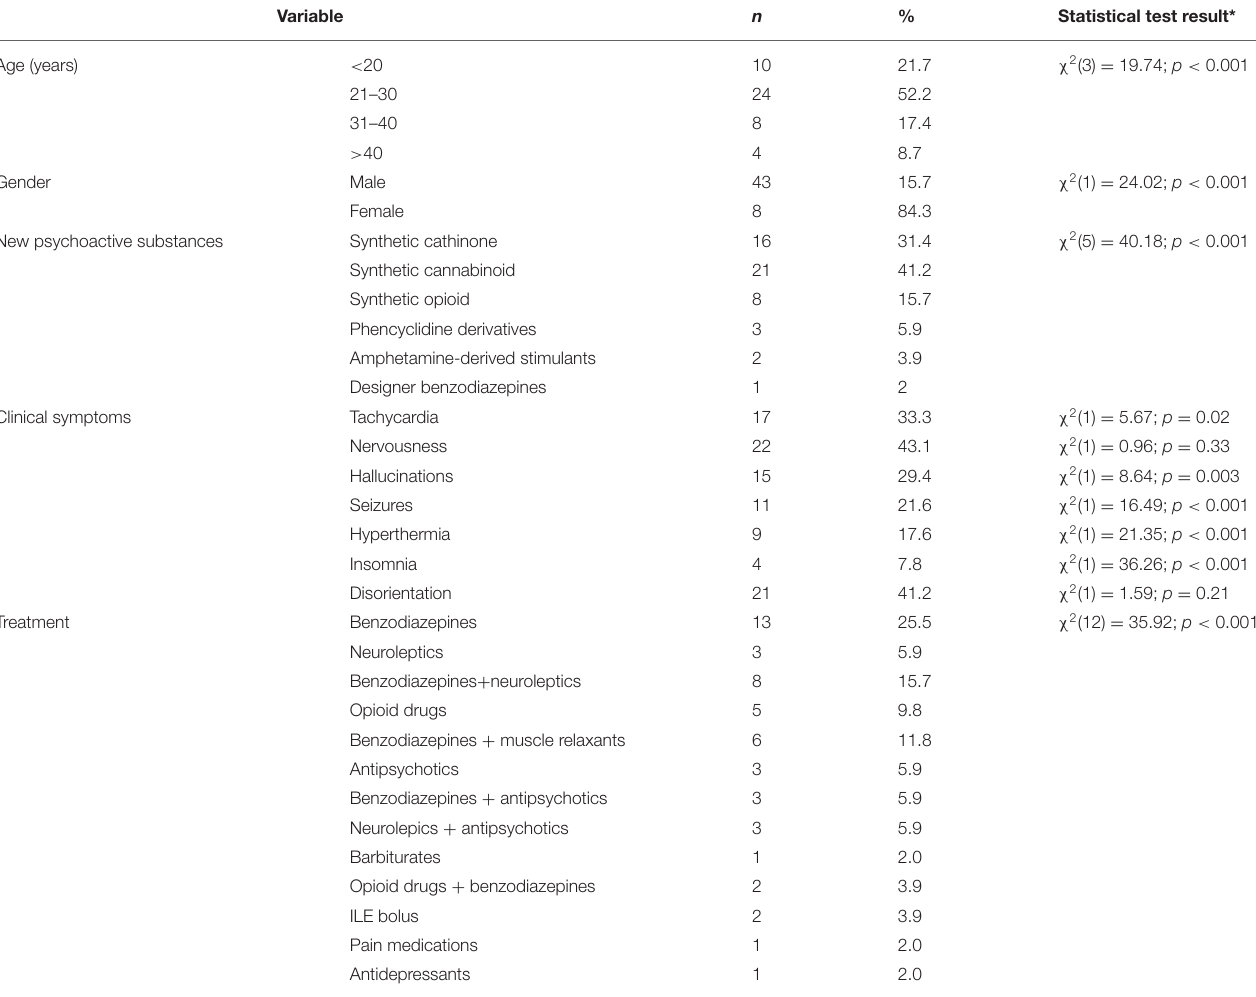
TABLE 2 | Age, gender, clinical symptoms and treatment of patients taking various types of NPS in reports written between 2010 and 2019; *chi-square. Variable n % Statistical test result*